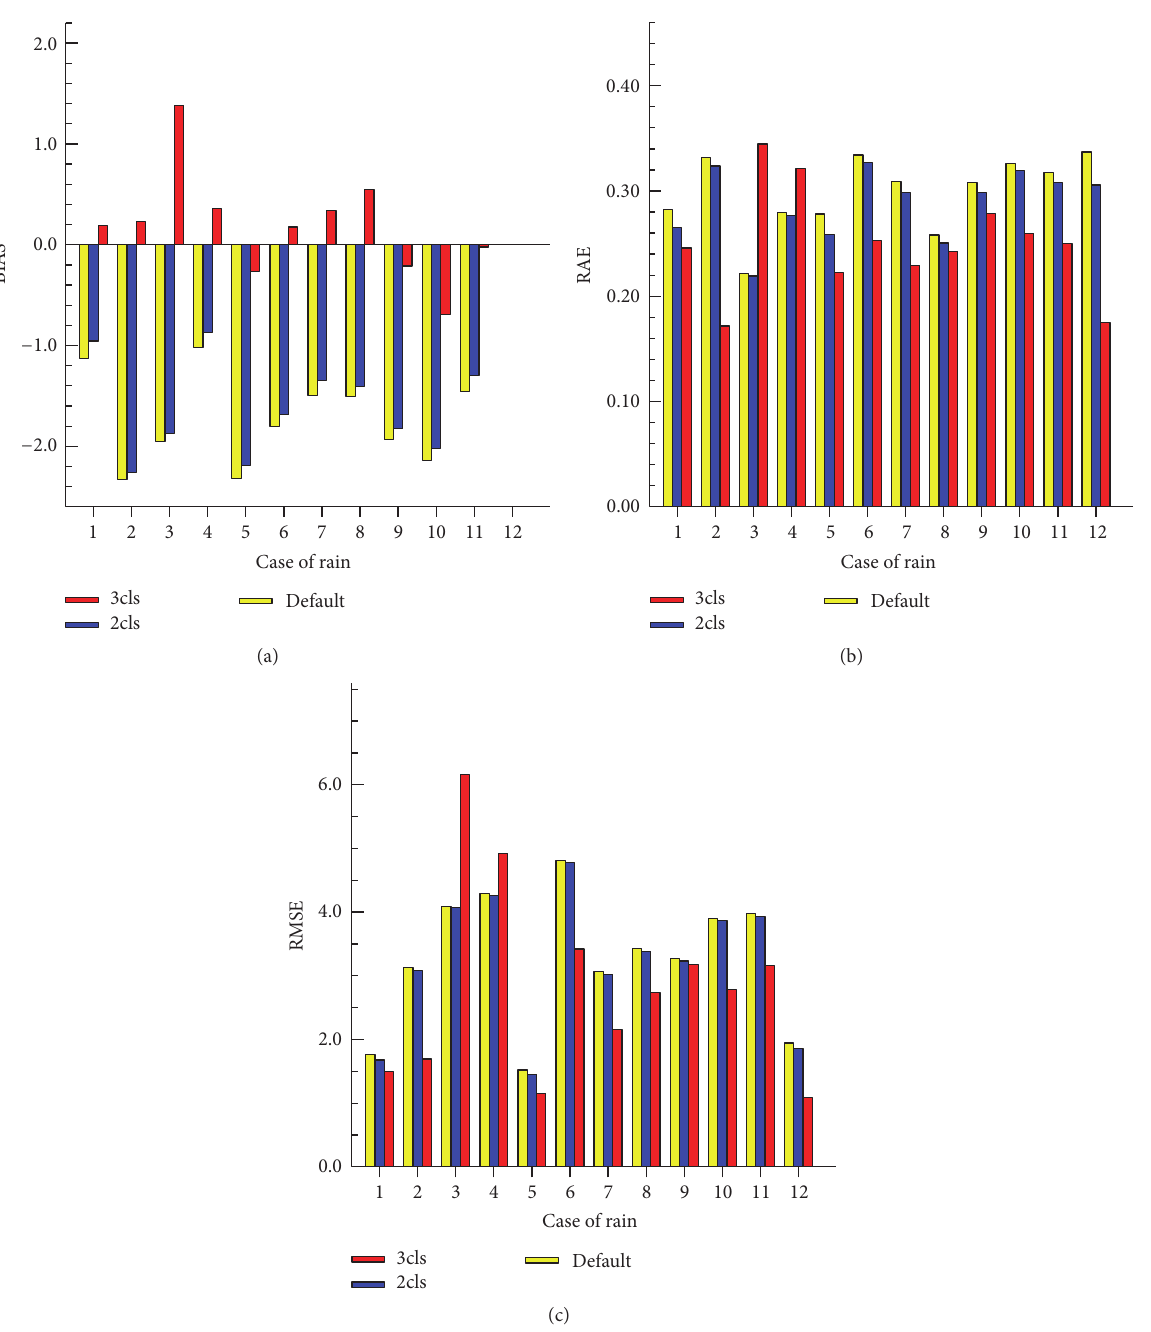
Figure 4: Error statistics considering only tropical rain events. Label “2cls” represents classification in two precipitation classes (Experiment II), and “3cls” represents classification in three precipitation classes (Experiment III). The units of BIAS and RMSE are mm; RAE is